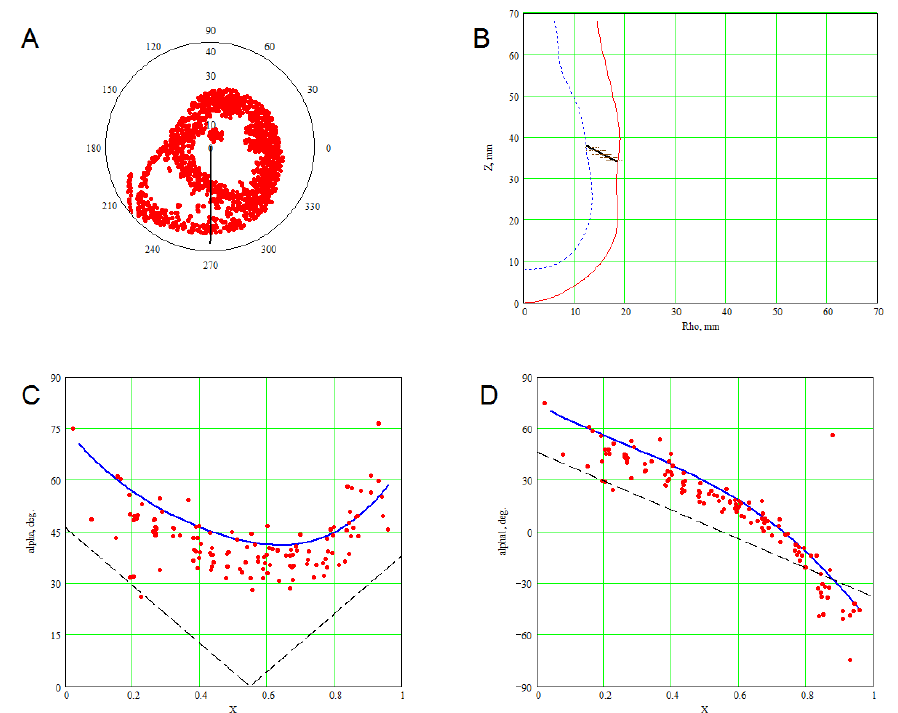
Figure 11. Fiber angles in the model and experimental data. The IVS in the middle area ( ψ = 30 ◦ ) is shown. The conventional signs are the same as in Figure